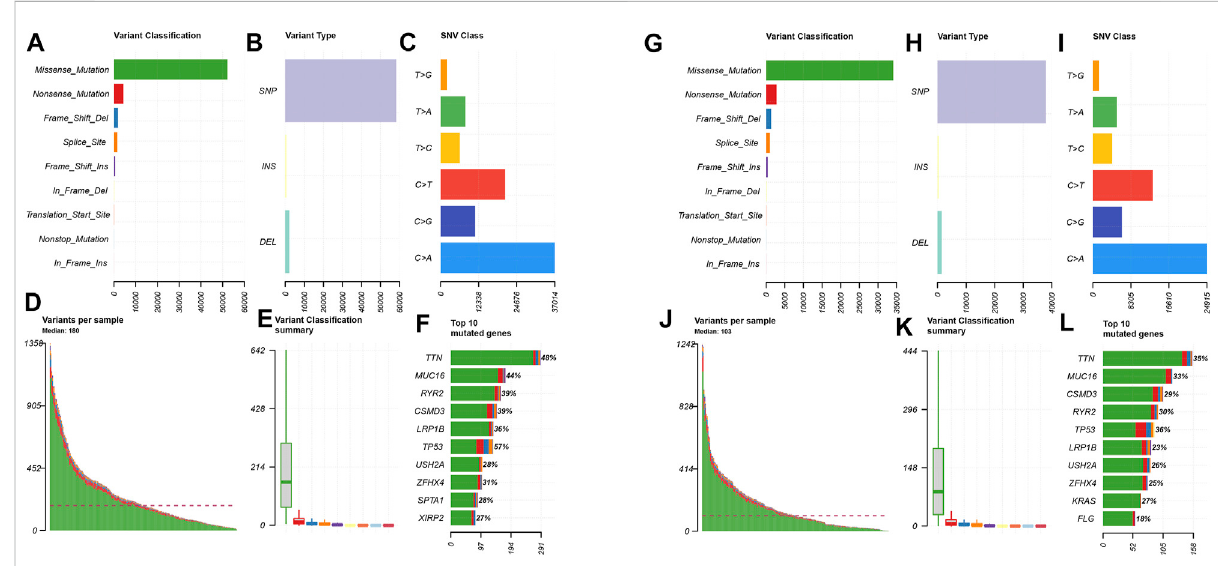
FIGURE 5 Distributionsofmutantgenesinhigh-andlow-riskgroups. (A) Variantclassi fi cationandfrequencyofgenemutationsinthehigh-riskgroup. (B) Variant type in the high-risk group. (C) Frequency of SNV classes in the high-risk group. (D) Median of variants per sample in the high-risk group. (E) Variant classi fi cation summary in the high-risk group. (F) List of top 10 mutated genes in the high-risk group. (G) Variant classi fi cation and frequency of gene mutations in the low-risk group. (H) Varianttype inthe low-risk group. (I) Frequency of SNV classes in the low-risk group. (J) Median of variants per sample in the low-risk group. (K) Variant classi fi cation summary in the low-risk group. (L) List of top 10 mutated genes in the low-risk